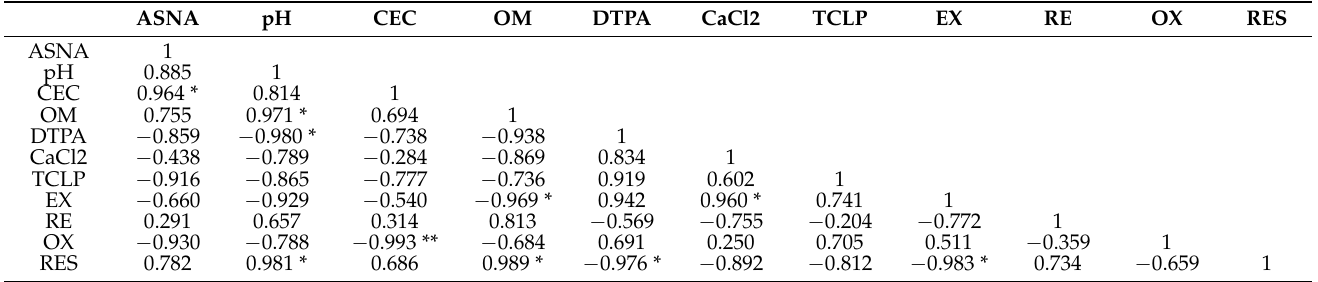
Table 3. Correlation analysis of Zn chemical speciation, bioavailability, ASNA addition, and soil physicochemical